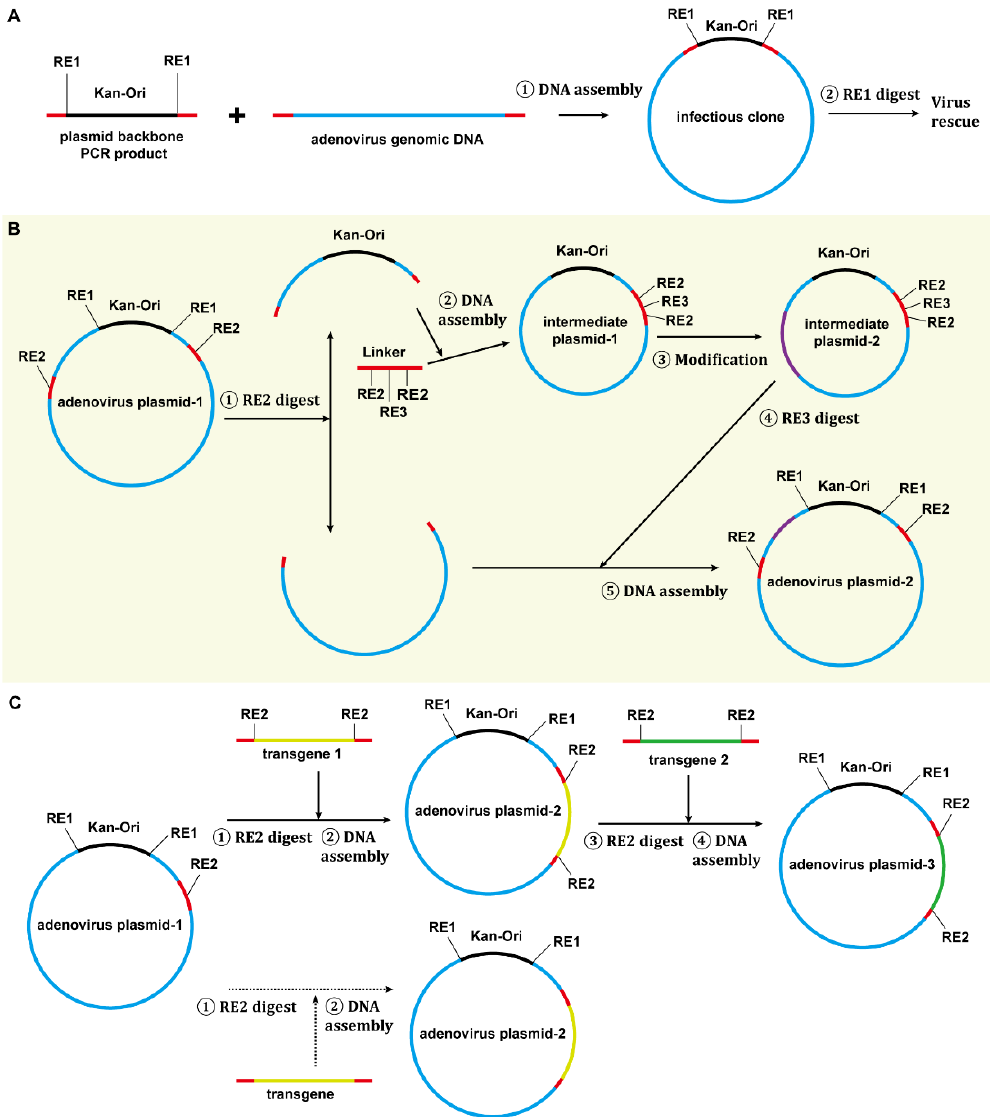
Figure 9. Strategies for adenovirus vector construction and modification. ( A ) Construction of an adenovirus infectious clone. ( B ) Construction or modification of a novel adenovirus vector system by the method of restriction-assembly. Intrinsically, it is an intermediate plasmid-based strategy to modify adenoviral genome where restriction-assembly simplifies the construction procedure. When adenovirus plasmid-1 is the infectious clone of a new serotype adenovirus, a novel vector system can be established by this strategy. If adenovirus plasmid-1 belongs to an existing vector system, it will generate a modified one. ( C ) Load a transgene to an adenovirus vector using the restriction-assembly method. The prerequisite of this procedure is that the start adenovirus plasmid (adenovirus plasmid-1) is constructed in advance to satisfy the requirement of restriction-assembly: a unique cutter site (RE2) is placed as the entrance for insertion of exogenous DNA. If RE2 sites are saved to flank the transgene-1, the product plasmid (adenovirus plasmid-2) can be re-used for loading other transgenes just as adenovirus plasmid-1 does. The RE2 site can be removed, if necessary, as shown by the dotted branch. Overlaps for Gibson assembly are shown in red. Kan-Ori: kanamycin-resistance gene and pBR322 origin of replication (plasmid backbone); RE: restriction enzyme.